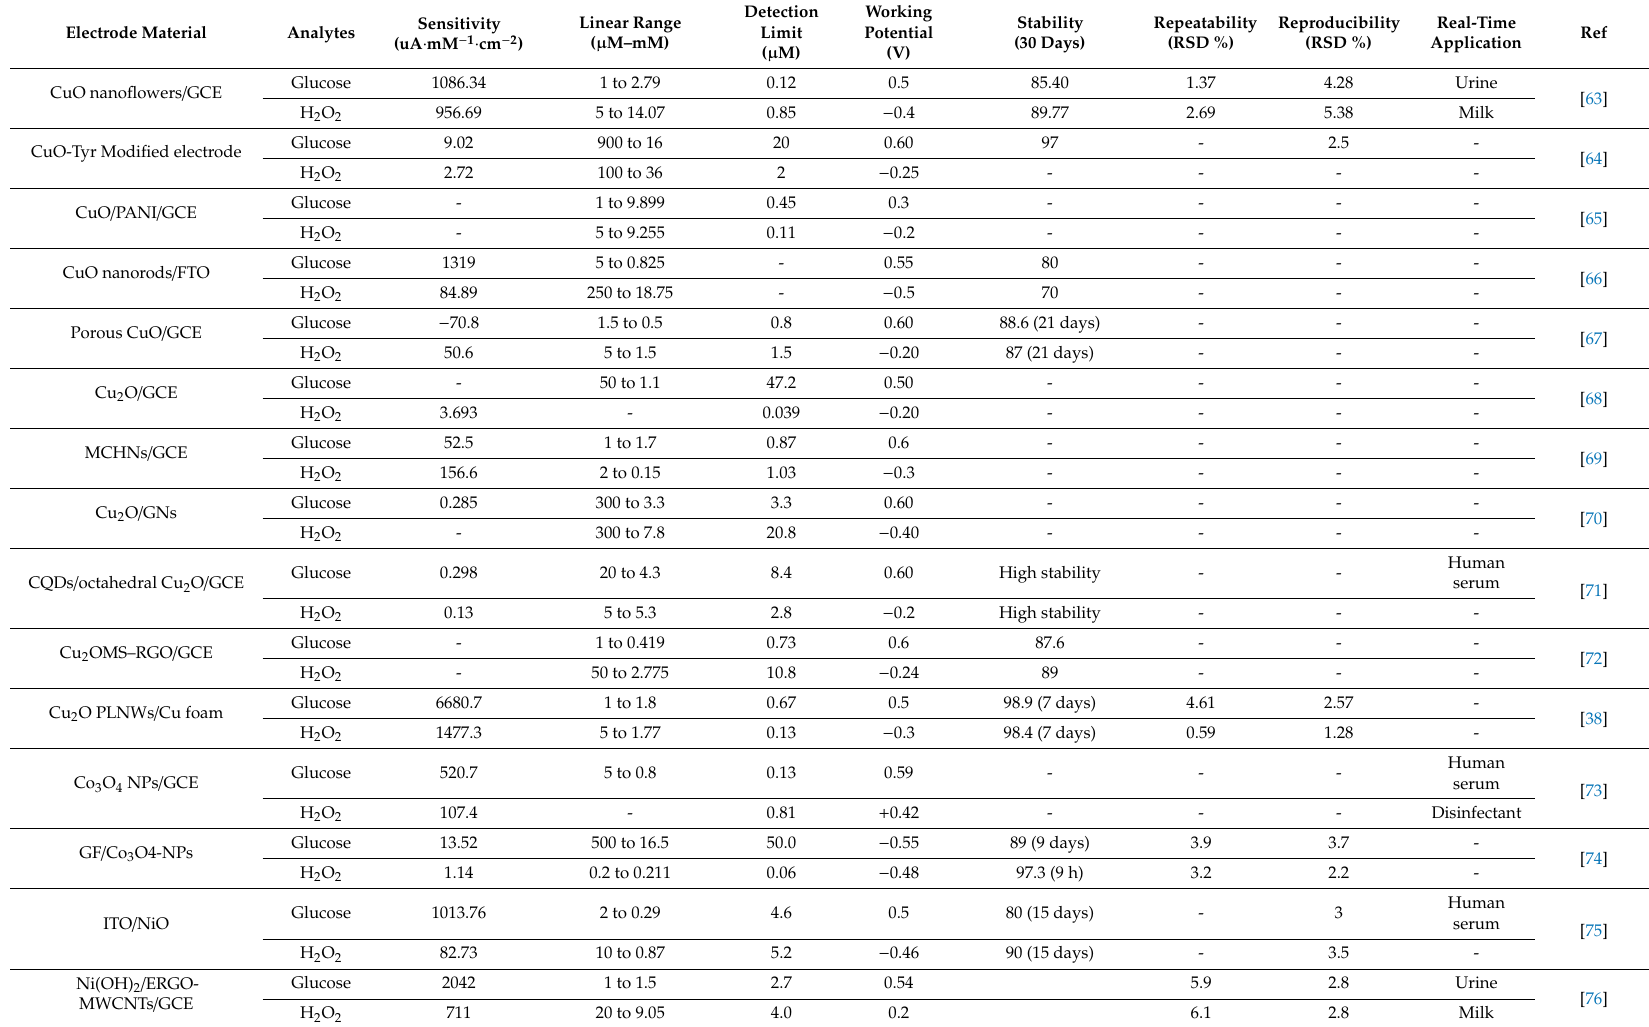
Table 2. Performance of non-enzymatic glucose and H 2 O 2 electrochemical sensors based on metal oxide nanocomposites. Electrode